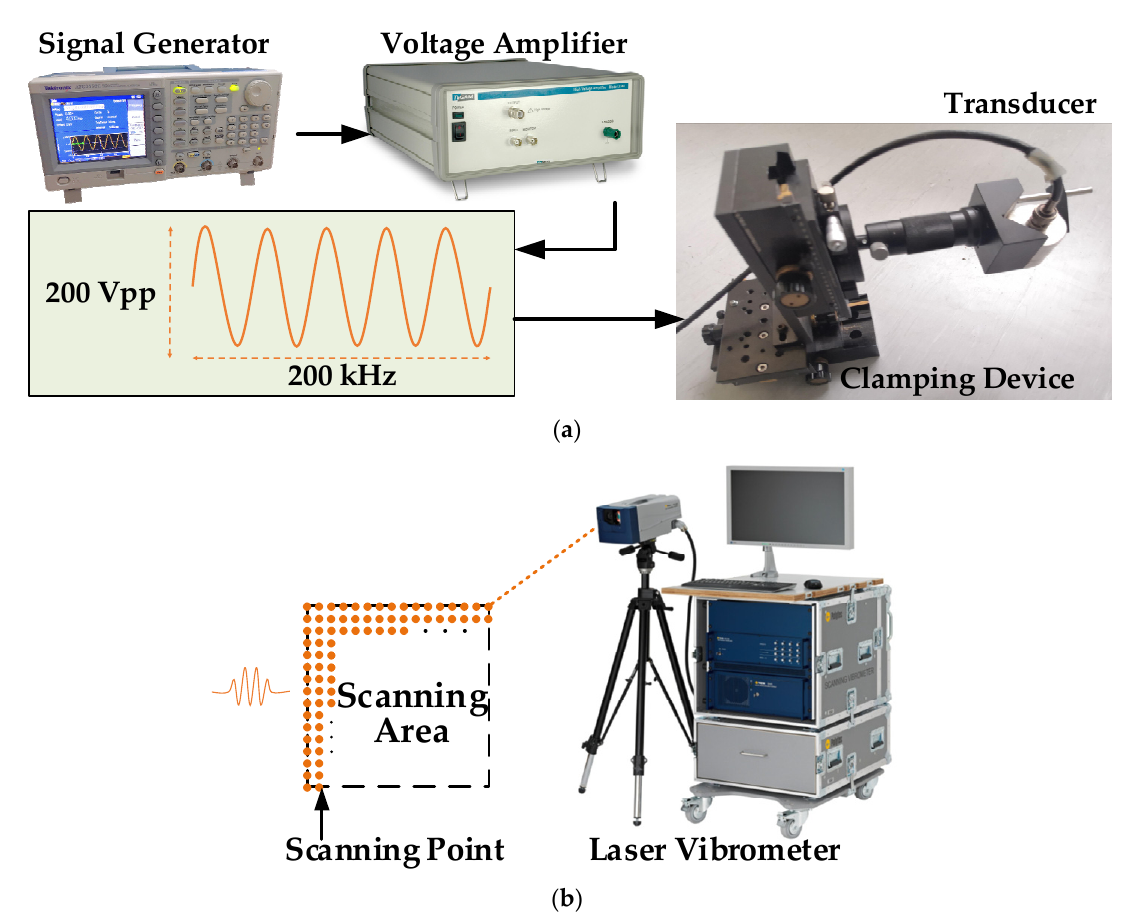
Figure 2. The specific composition of the system in the experiment: ( a ) the ultrasonic transmitting component; ( b ) The signal receiving component.